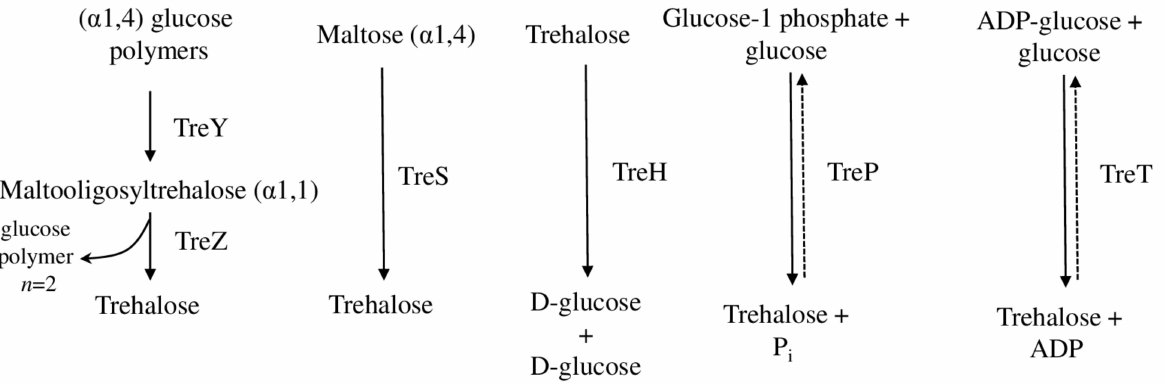
Figure 2. The trehalose biosynthetic pathways. TreY (maltooligosyl–trehalose synthase), TreZ (maltooligosyl–trehalose trehalohydrolase), TreS (trehatose synthase), TreH (trehalase), TreP (trehalose phosphorylase), TreT (trehalose glycosyl-transferring